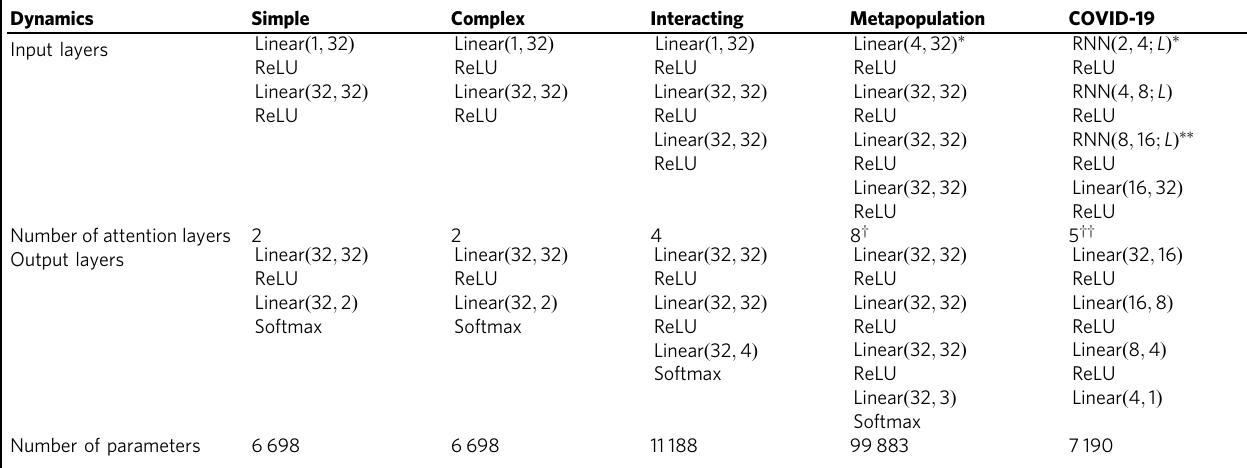
Foreachsequence,theoperationsareappliedfromtoptobottom.TheoperationsrepresentedbyLinear( m , n )correspondtolinear(oraf fi ne)transformationsoftheform f ( x ) = Wx + b ,where x 2 R m is the input, W 2 R n ´ m and b 2 R n are trainable parameters. The operation RNN( m , n ; L ) corresponds to an Elman recurrent neural network module 68 with m input features and n output features applied on sequences of length L 68 . The operations ReLU and Softmax are activation functions given by ReLU ð x Þ ¼ max x ; 0 f g and Softmax ð x Þ ¼ exp ð x Þ ∑